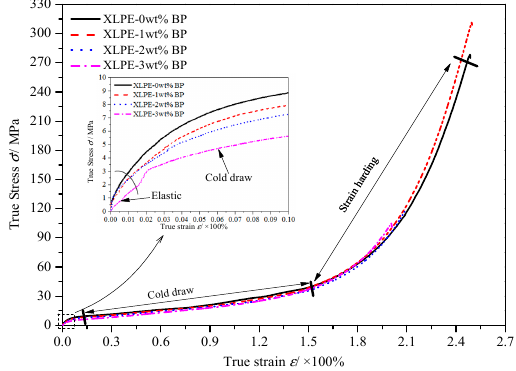
Figure 4. True stress–strain curves.